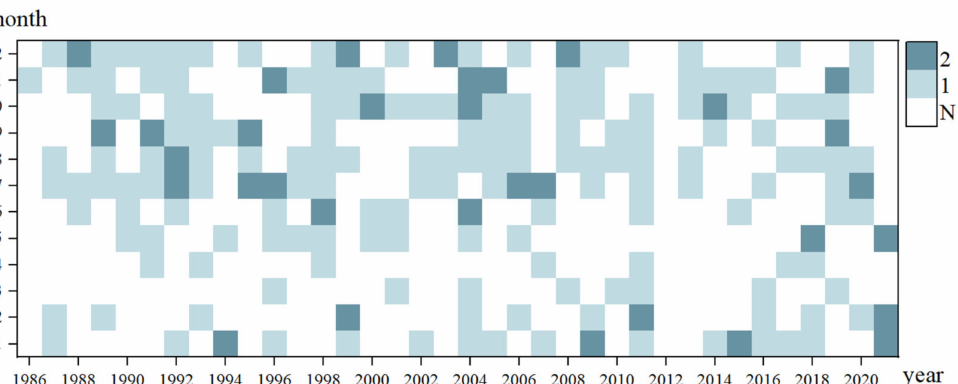
Figure 4. Monthly availability of Landsat and Sentinel-2 images for SSC mapping. (N refers to the unavailability of images in the specific month, the color depth represents the number of images in the corresponding month, and the dark color represents two scene images